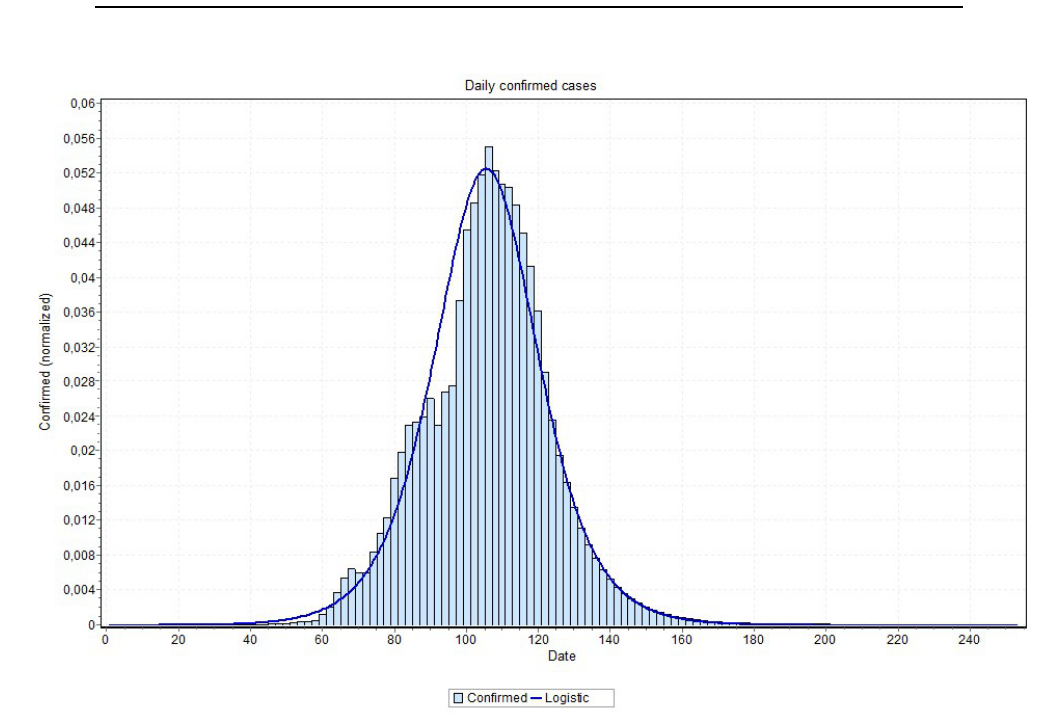
Figure 18. Curve fitting for Rio de Janeiro state (logNormal model was the best fit) with peak